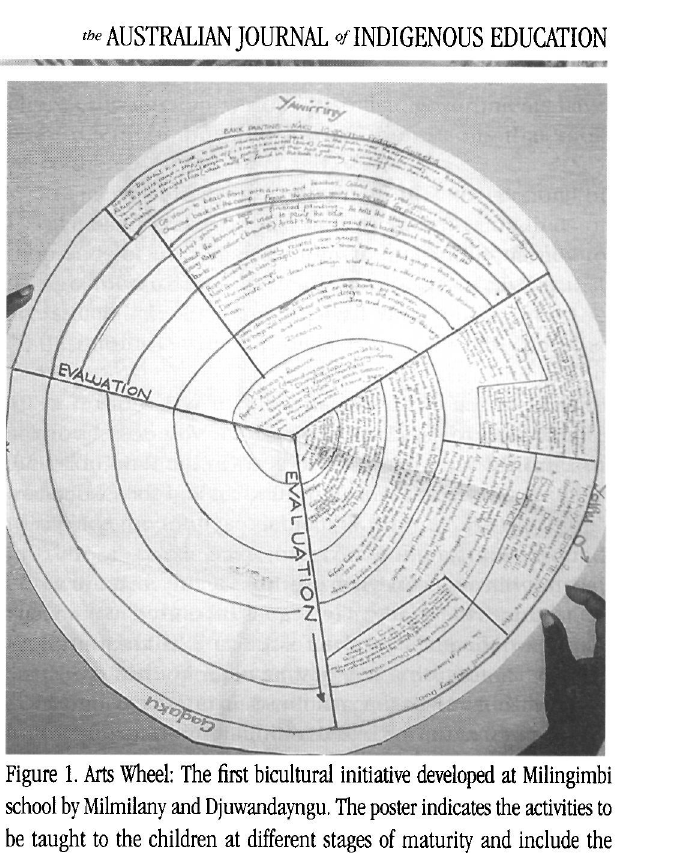
Figure 1. Arts Wheel: The first bicultural initiative developed at Milingimbi school by Milmilany and Djuwandayngu. The poster indicates the activities to be taught to the children at different stages of maturity and include the evaluation